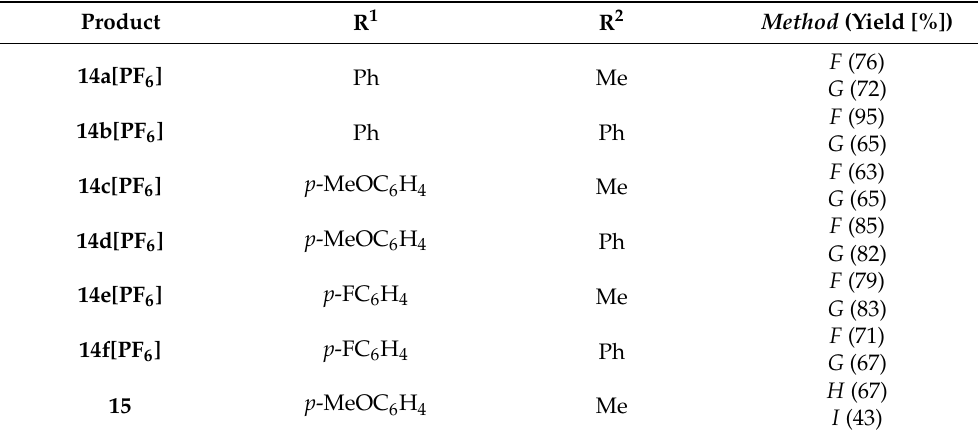
Table 2. Synthesis of alkoxy-imidazolium salts of type 14[PF 6 ] and the sulfurization of 14c[PF 6 ] ; comparison of mechanochemical ( Methods G and I ) approaches with reactions in solution ( Methods F and H ) a